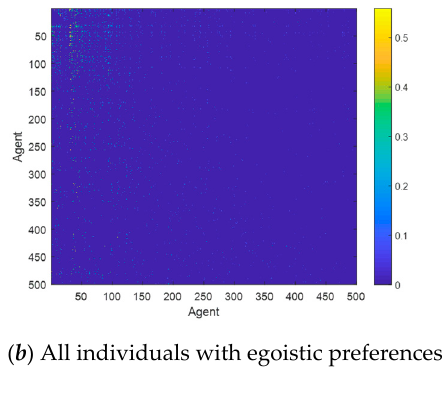
Figure 11. Distributions of intimacy degree.